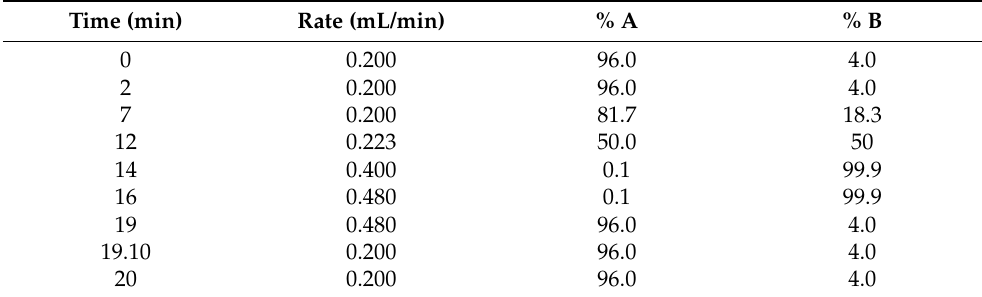
Table 1. Gradient elution and rate flow used in the chromatographic separation. Time